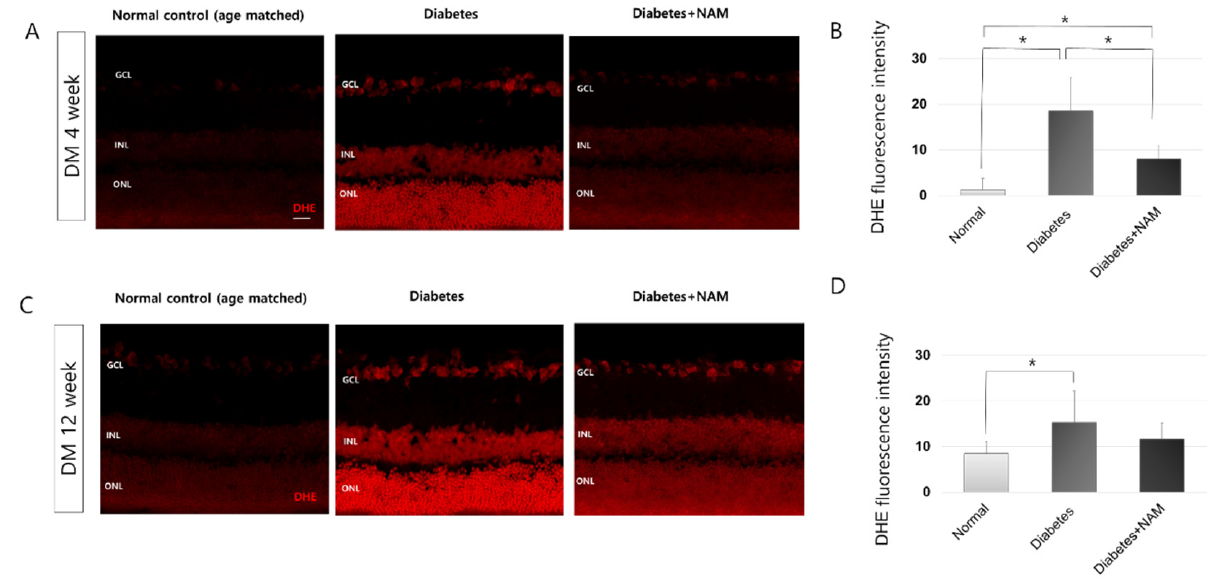
Figure 4. Dihydroethidium (DHE) staining, which detects superoxide ( A – D ). Four and twelve weeks after induction of diabetes, retinas showed extensively increased staining for DHE spanning the vertical retinal section (both p < 0.001). Nicotinamide treatment reduced DHE expression at 4 weeks after onset of diabetes ( p < 0.001). DHE, dihydroethidium; DM, diabetes mellitus; NAM, nicotinamide. Scale bar = 20 µ m. GCL, ganglion cell layer. INL, inner nuclear layer. ONL, outer nuclear layer. *, significantly different as indicated ( p < 0.05).